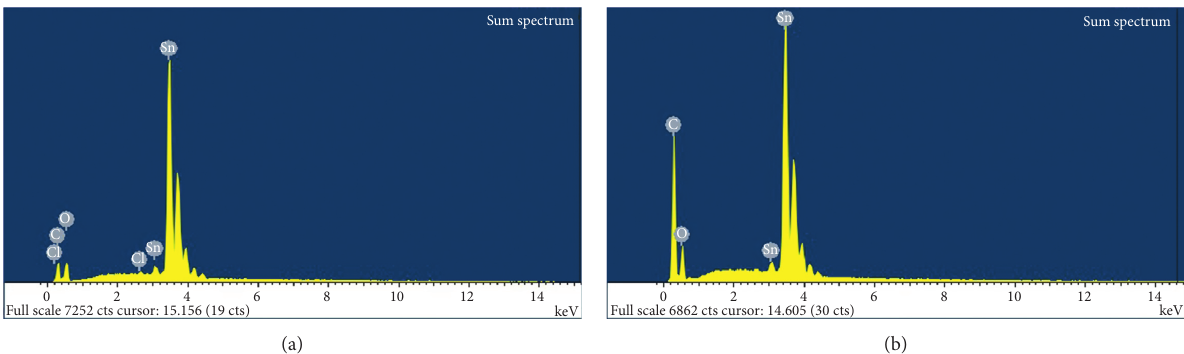
Figure 6: EDX spectra data for SnO